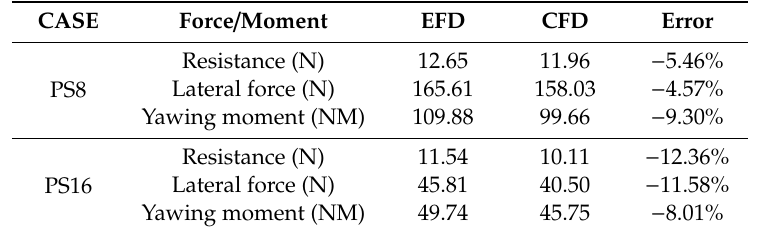
Table 6. Comparison between the calculated and experimental forces and moment in pure sway tests.